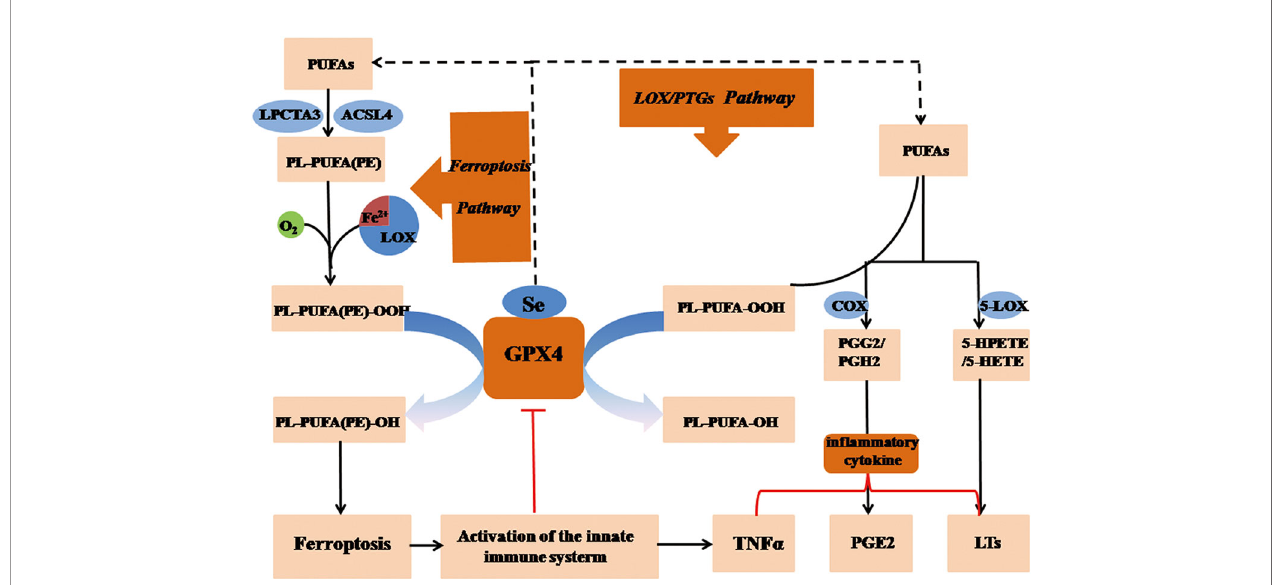
FIGURE 4 | GPX4 regulates necroin fl ammation via arachidonic acid metabolism in ferroptosis. Peroxidized lipids and imbalanced metabolic arachidonic acid (AA) are comprised in ferroptotic process, which exerts an regulatory impact on the process of necroin fl ammatory response. Upregulation of GPX4 might results in a reduction in the cellular lipid hydroperoxide level, which inactivates PTGS and LOX, eventually inhibiting eicosanoid synthesis. The antioxidative enzyme GPX4 alleviates in fl ammatory response through eliminating oxidative materials produced in AA metabolism, and regulates the in fl ammatory state by modulating LOX and PTGS activity in ferroptosis. GSH, reduced glutathione; GSSG, oxidized glutathione; LOX, lipoxygenase; GPX4, glutathione peroxidase 4; H 2 O 2 , hydrogen peroxide;